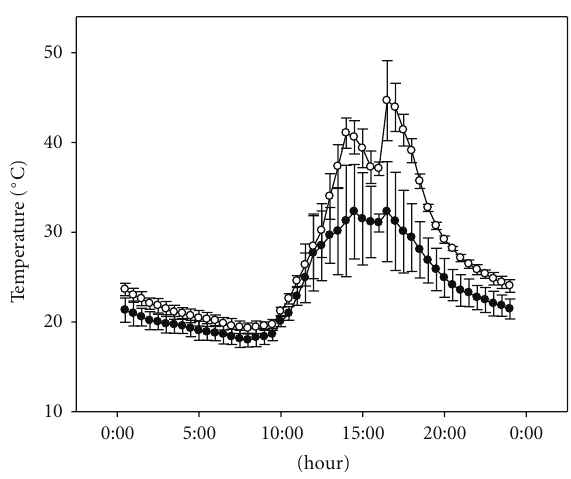
Figure 1: Daily soil temperature (mean ± S.D.; n = 3) in ( ◦ ) open sites (deprived of vegetation in the dry season) and ( • ) closed sites (beneath the canopy of perennial vegetation) in the Reserva Ecol´ogica del Pedregal de San ´Angel,